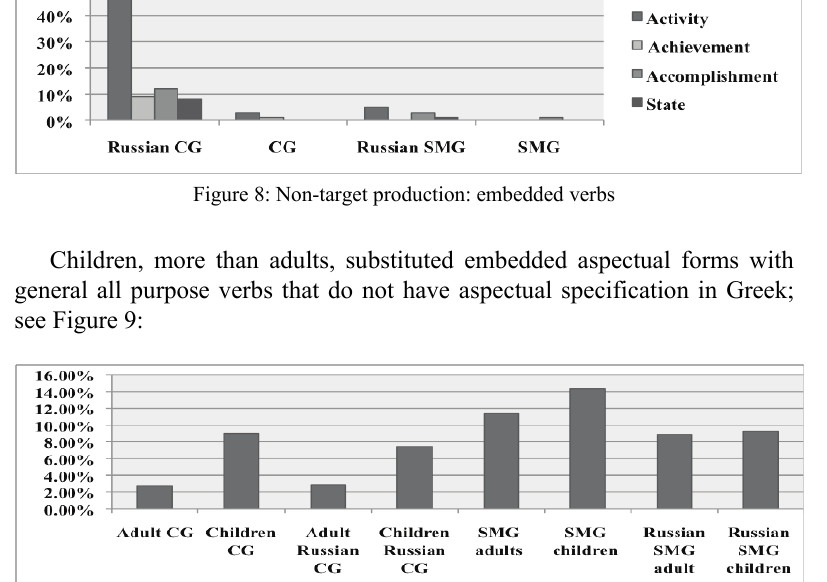
Figure 9: Non-target production: GAP verbs